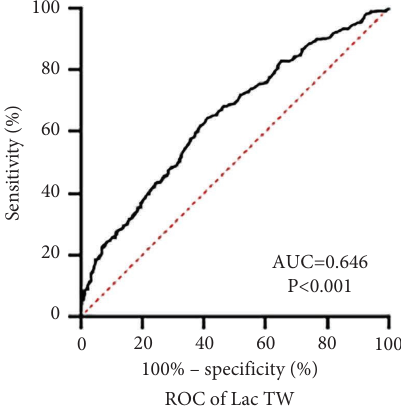
Figure 1: ROC curve of LacTW for predicting mortality. Note. Te cutof value of LacTW for predicting mortality was 1.975 mmol/L, and it has a sensitivity of 64.1% and a specifcity of 59.2% (AUC � 0.646, P < 0.001, and 95% CI: